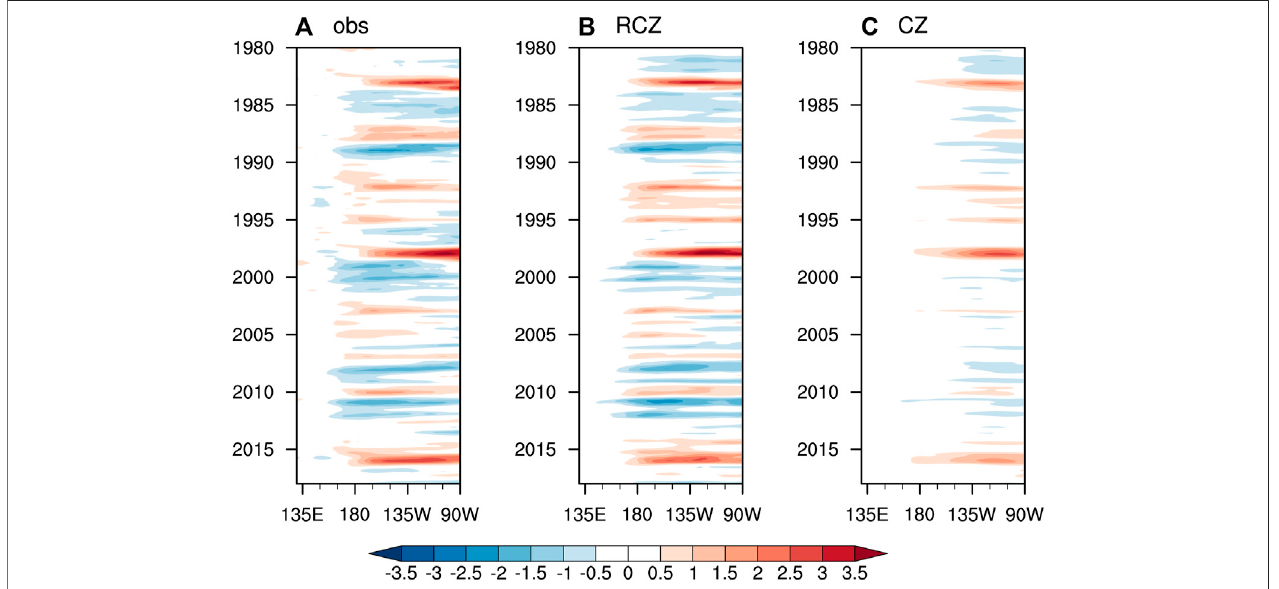
FIGURE 7 | Time evolution of (A) the observed, (B) the RCZ-simulated, and (C) the CZ model-simulated equatorial (5 ° S – 5 ° N average) SSTA (unit: ° C) during 1980 – 2018. The model simulations are performed with the oceanic component only and are driven by the observed wind stress anomalies.